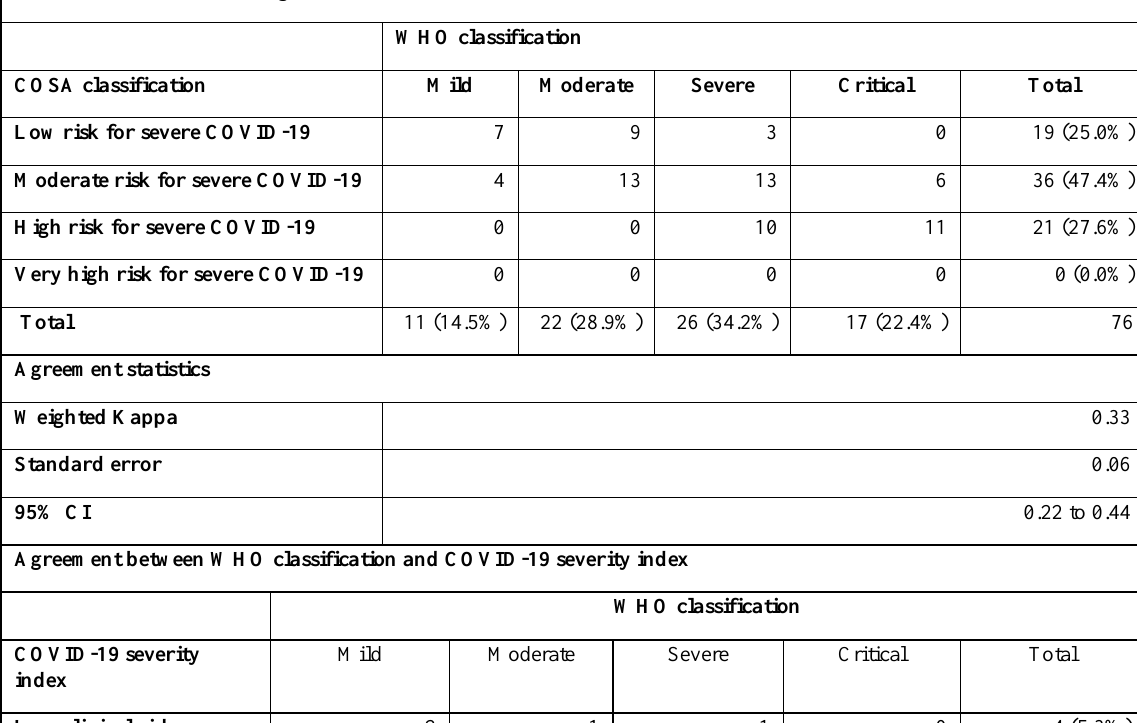
Table 5. Inter method agreement between WHO classification, COSA classification and COVID-19 Severity